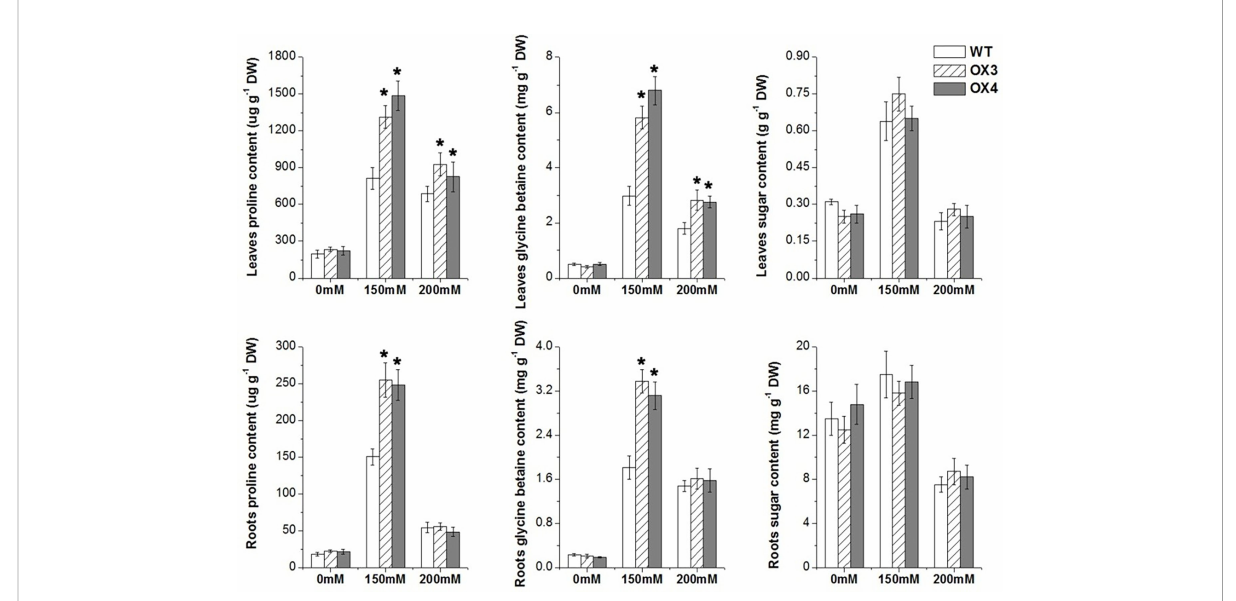
FIGURE 8 Osmolyte contents in leaves and roots of ZmGnTL transgenic Arabidopsis . ZmGnTL -OX plants and WT were treated with 0 mM, 150 mM, and 200 mM NaCl for 10 days. Data are show as means ± SE of three to fi ve biological replicates, and * indicated statistical signi fi cance at *P< 0.05.